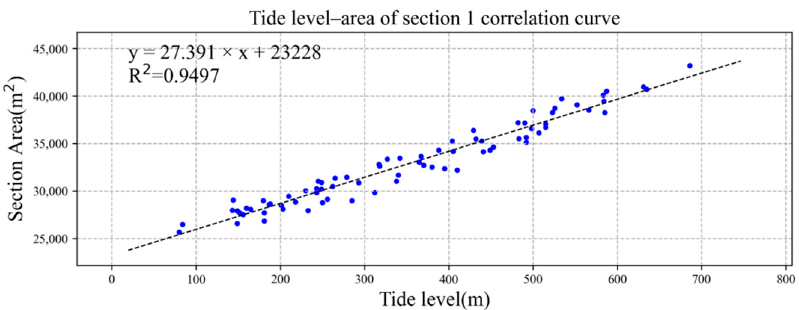
Figure 7. Linear correlation between tide level and section 1 area. The data of blue dots represent the relationship between tide level(x) and area of section 1(y).